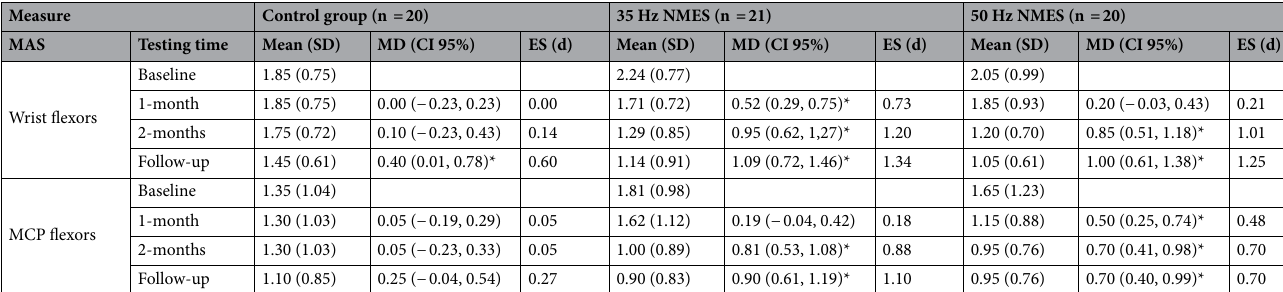
Table 4. Means, standard deviations, mean differences, confidence intervals and effect sizes of the variables related to muscle tone in all the time points. MAS Modified Ashworth Scale, MCP Metacarpophalangeal,